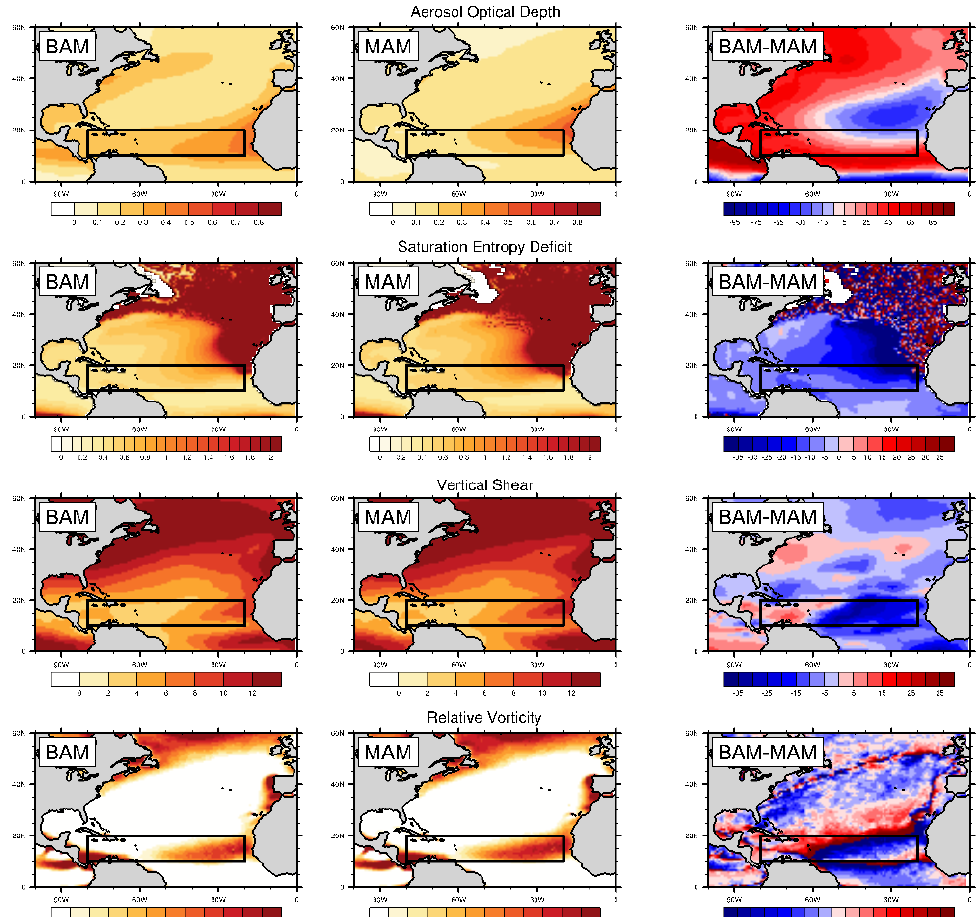
Figure 3. Seasonal (June – November) average from 1982 to 2005 for (first row) AOD, (second row) saturation entropy deficit, (third row) vertical shear (m/s) between 850 and 200 hPa, and (fourth row) relative vorticity (1/s) at 850 hPa. The results are shown for the model simulations with (left column) BAM, with (middle column) MAM, and (right column) the percent change between the two models. The MDR is displayed as the black outline.